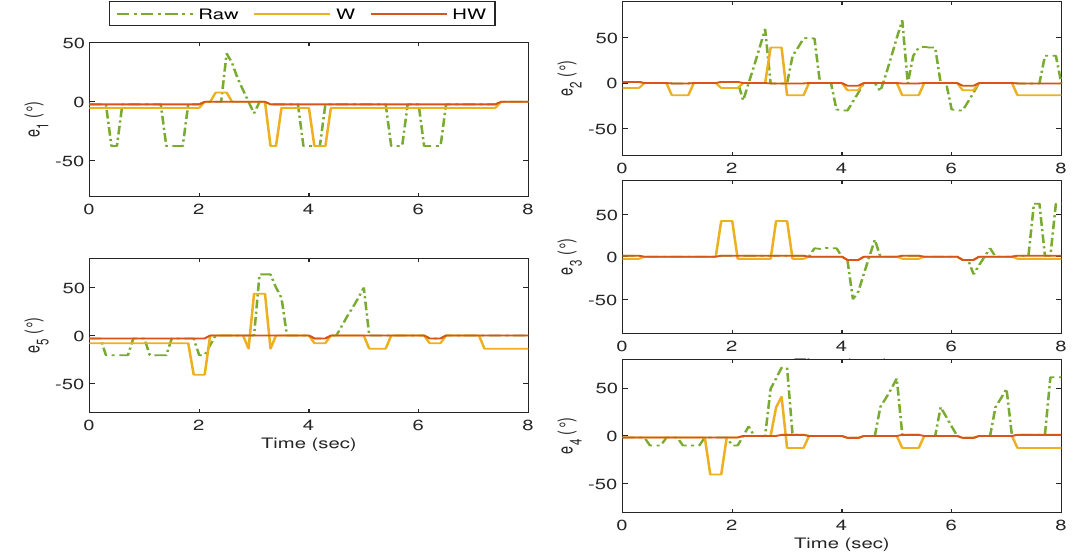
Figure 24. Gesture 6: The corresponding error from the response in Figure 23. The error due to the response from Compensator HW is the least at all time instances as compared to the others. Some images taken from the camera during the performance evaluations are shown in Figure 25. Each of them illustrates the final position of each finger for each gesture (i.e., grab, number two, call, and okay signs).